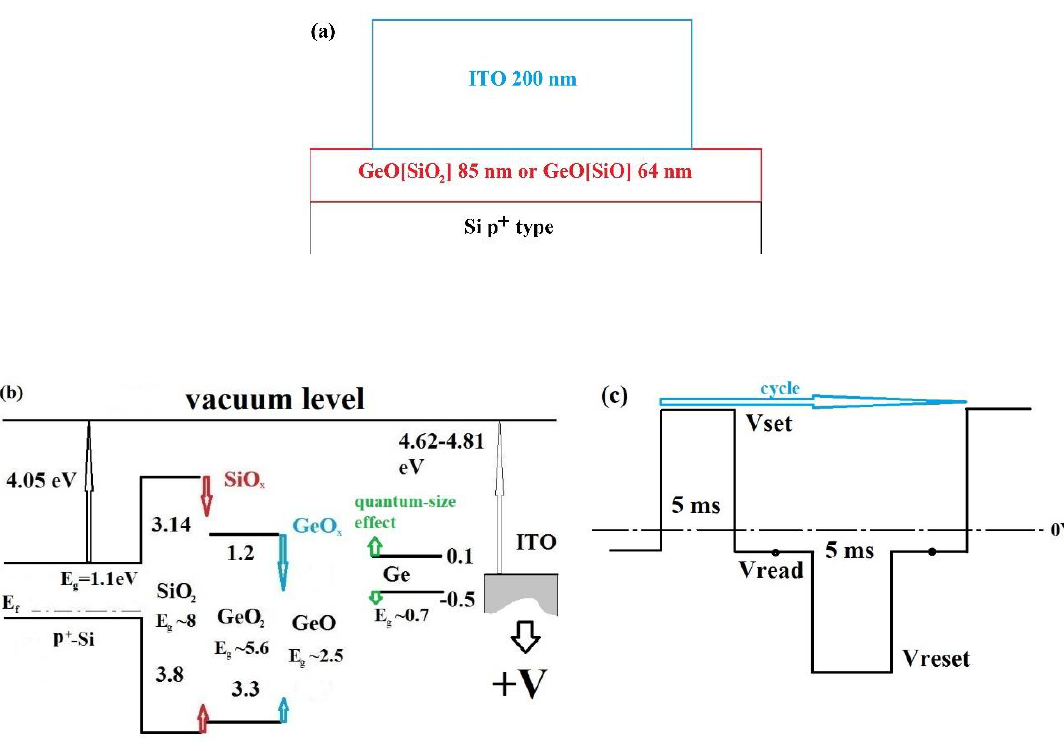
Figure 5. ( a ) Schematic image of the metal–insulator–semiconductor (MIS) structures. ( b ) The scheme of the corresponding energy band diagram. ( c ) The scheme of the measurements of endurance.